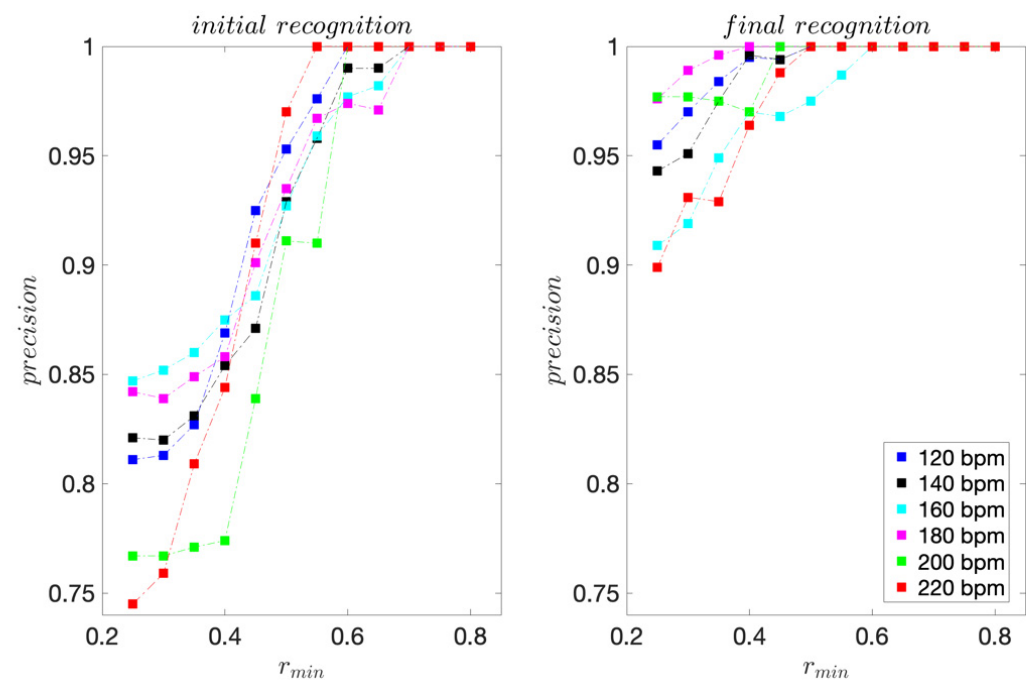
Figure 7. Precision scores obtained for the recreational dancers’ test sequences.